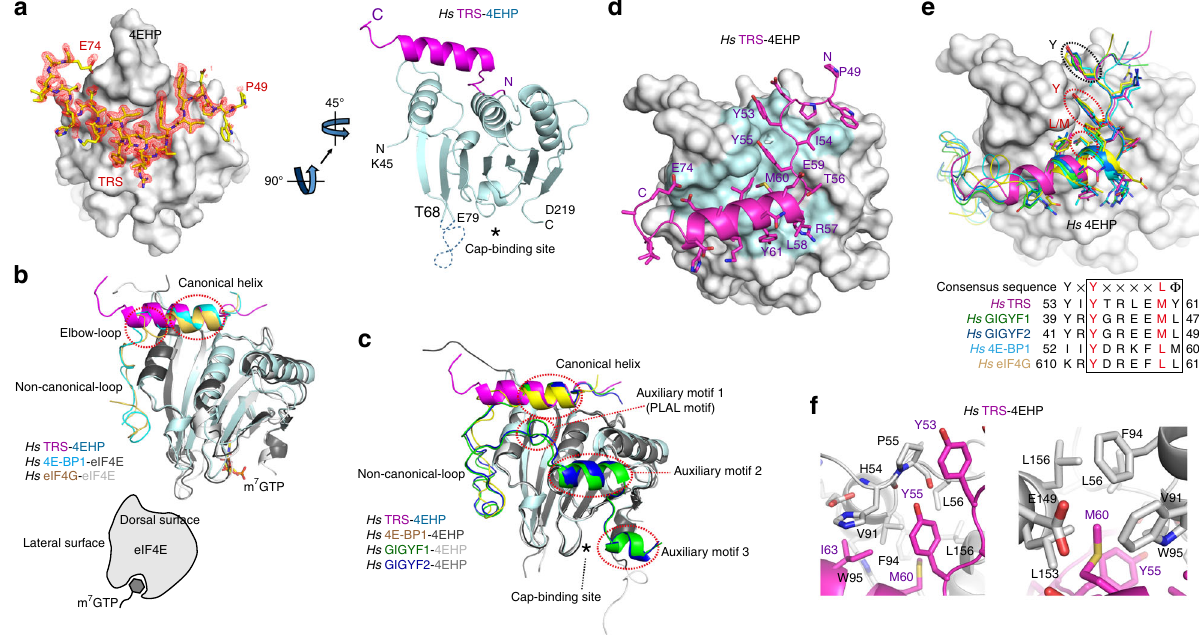
Fig. 2 The structure of the TRS UNE-T region bound to 4EHP implies that it is part of the translation initiation complex. a Overall structure of the TRS UNE- T-4EHP complex. The F o − F c electron density map of TRS UNE-T is displayed using surface representation of 4EHP calculated before the inclusion of TRS UNE-T, and contoured at 2.5 σ . The TRS UNE-T (magenta)-4EHP (pale cyan) complex is shown in cartoon representation. The disordered region in 4EHP (residues Pro69 − Tyr78), which was not observed in the electron density map, is indicated by the dashed line. The asterisk indicates the cap-binding site in 4EHP. Hs , Homo sapiens . b Superimposition of the structures of the 4E-BP1 (cyan)-eIF4E (dark gray) and eIF4G (yellow)-eIF4E (light gray) complexes onto that of TRS (magenta) bound to 4EHP (pale cyan). The m 7 GTP cap analog bound to eIF4E is shown in stick representation. Dorsal and lateral surfaces are indicated. c Superimposition of the structures of the 4E-BP1 (yellow)-4EHP (dark gray), GIGYF1 (green)-4EHP (light gray), and GIGYF2 (blue)-4EHP (gray) complexes onto that of TRS (magenta) bound to 4EHP (pale cyan). d , e Interactions between TRS and 4EHP mediated by the canonical eIF4E/4EHP- binding motif. TRS residues (magenta) involved in the interaction with 4EHP are shown in stick representation ( d ). Surface region (pale cyan) of 4EHP residues responsible for interactions with TRS ( d ). eIF4E/4EHP-interacting proteins superimposed on the TRS-4EHP complex ( e ). Sequence alignment of the eIF4E/4EHP-binding consensus motif. Y and L/M of the consensus sequences (YX 4 L ϕ ) and Y of the additional N-terminal residues (YX) are highlighted by red and black dotted circles, respectively ( e ). f Features of TRS Tyr55 (left) and Met60 (right) interacting with motif of 4EHP (corresponding to H37-P38-L39 in eIF4E) (Fig. 2f,